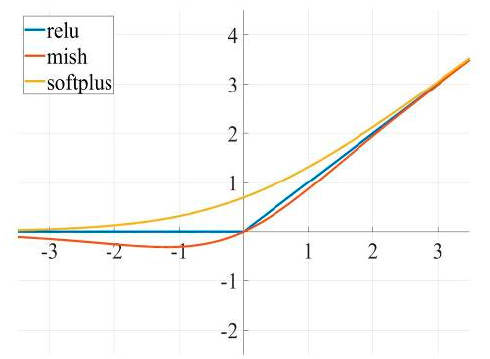
Figure 5. Common Activation Functions.